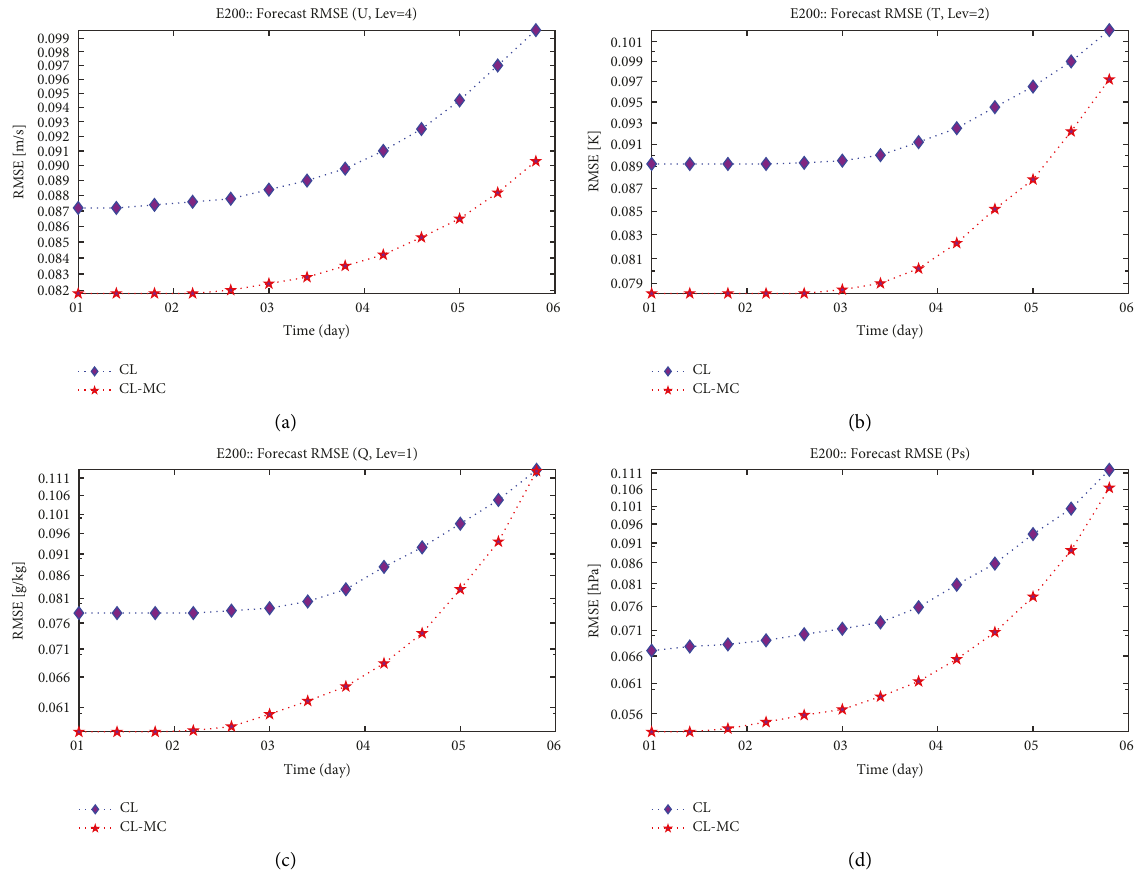
Figure 8: Experiment results with the SPEEDY model. Global mean 6-day forecast RMSEs averaged from 0000 UTC 1 March to 0000 UTC 1 May for (a) zonal wind (ms − 1 ) at the fourth model level ( ∼ 510hPa), (b) temperature (K) at the second model level ( ∼ 835 hPa), (c) specific humidity (gkg − 1 ) at the lowest level ( ∼ 925 hPa), and (d) surface pressure